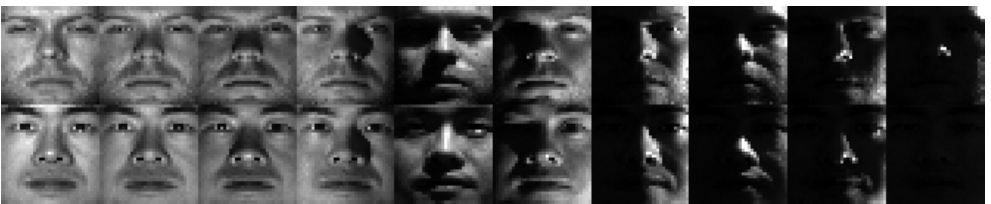
Figure 11. The typical images of the Extended YaleB face